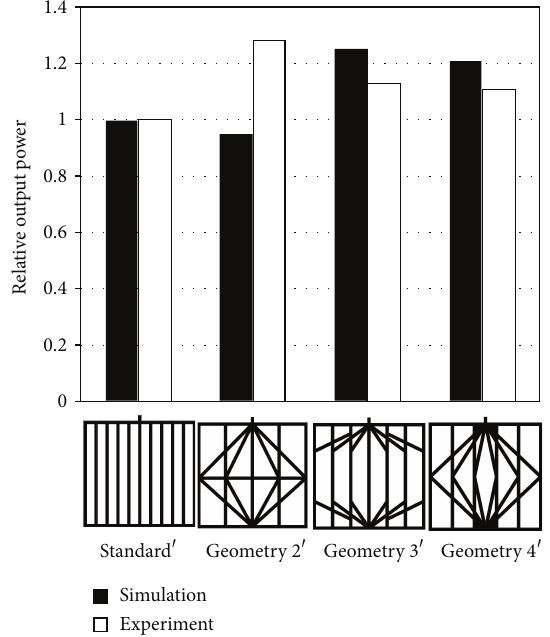
Figure 15: Comparison of the simulated and experimental